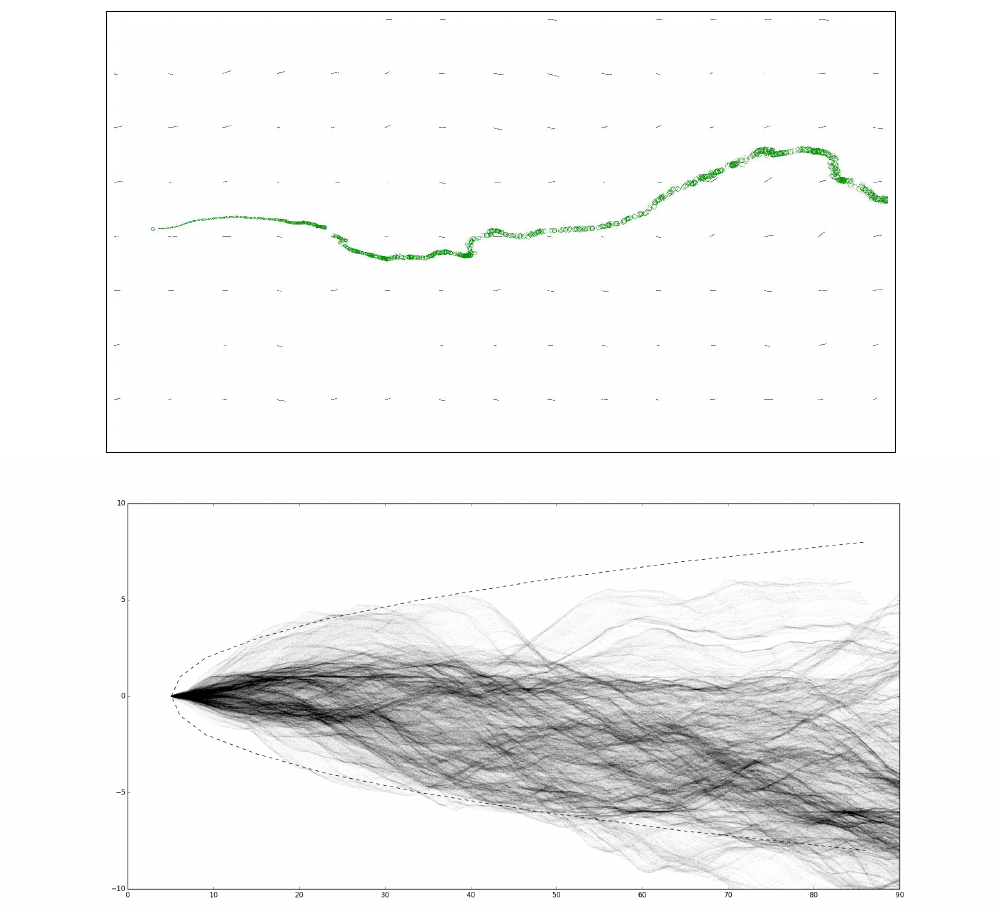
Figure 4. ( Top ) A 100 m by 50 m cut-out of the meandering plume generated by the proposed simulator. ( Bottom ) Time-averaged chemical concentration emitted over 600 s (faded curves, whose transparency is proportional to the mean concentration), surrounded by the Gaussian Plume model (dashed